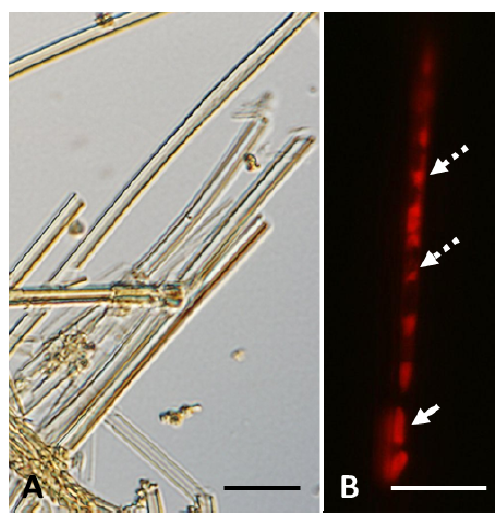
Figure 1. Sheaths produced by Leptothrix ochracea harvested from natural aquatic environment. ( A ) Thick, yellowish-brown, empty sheaths and ( B ) entire bacterial cell (solid arrow) and proteinic remnants (dotted arrows) within a sheath detected by protein-specific reagent, Ruby. Scale bar = 10 μ